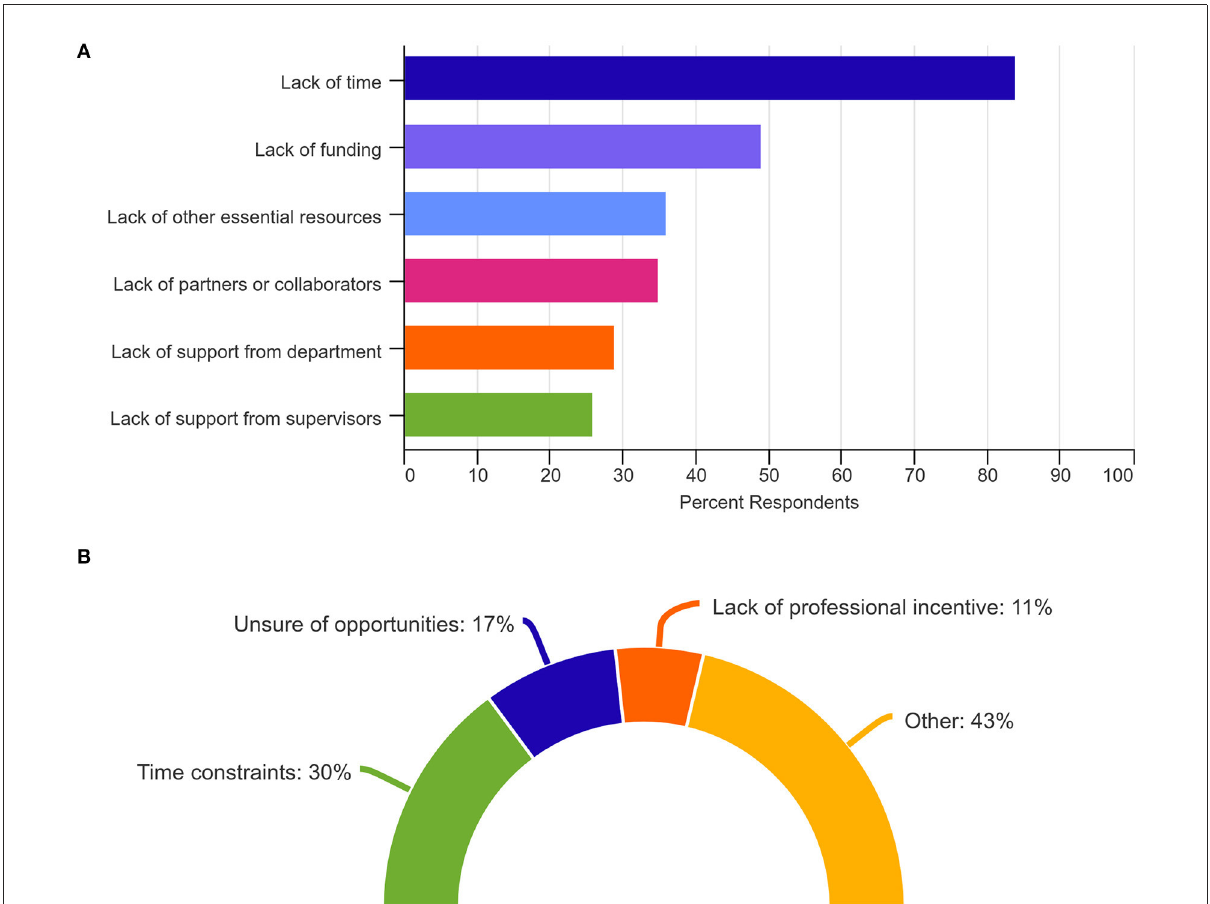
FIGURE6 Barriers to respondents’ participation in science outreach. (A) Percentage of respondents ( n = 488) who indicated that they experience barriers which hinder their participation in science outreach. (B) Percentage of codes ( n = 31) associated with respondents’ qualitative responses to the question, “I do not participate in science outreach